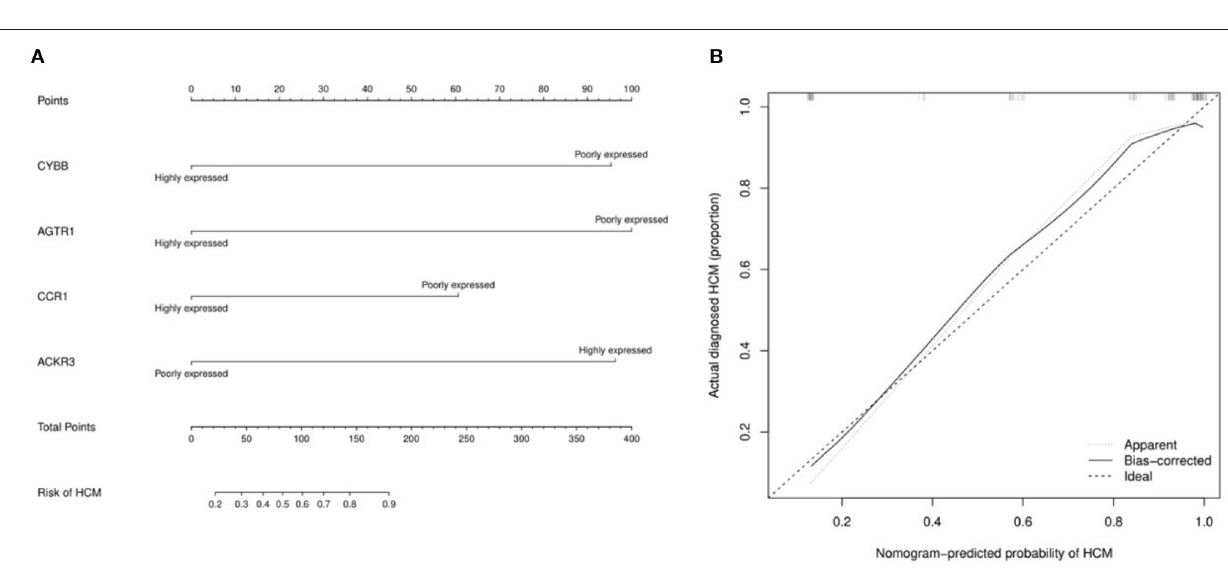
FIGURE 8 | The nomogram and calibration curve of the diagnosis model for hypertrophic cardiomyopathy based on four feature immune-related genes. (A) Nomogram for the diagnosis model of HCM. The observed value of each feature gene was assigned a certain number of points by drawing a vertical line toward the top points scale. The sum of the points for each gene corresponded to the individual risk of HCM. (B) Calibration curve for the diagnosis model of